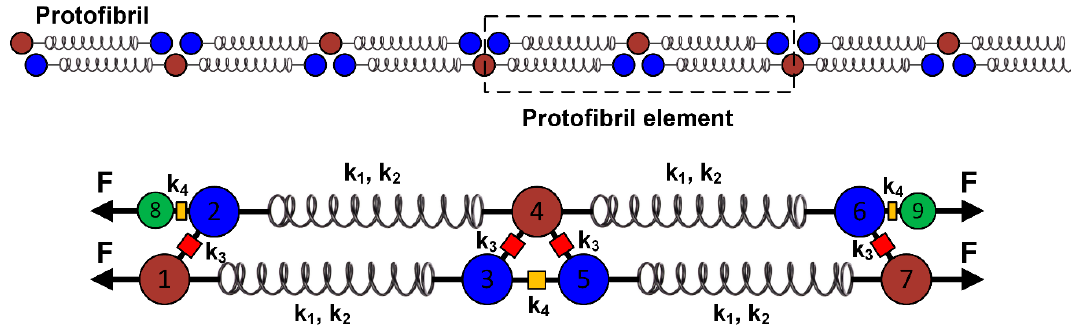
Figure 3. Development of a protofibril element using the nonlinear spring network. A portion of the double stranded protofibril (top) was considered in the development of the nonlinear protofibril element (bottom). Numbering of D- and E-regions from 1 to 9 is for convenience, where k 1 and k 2 represent spring constants. Constants k 3 and k 4 are components of the force coupling equations described in the manuscript. F is the applied force required to extend the protofibril.